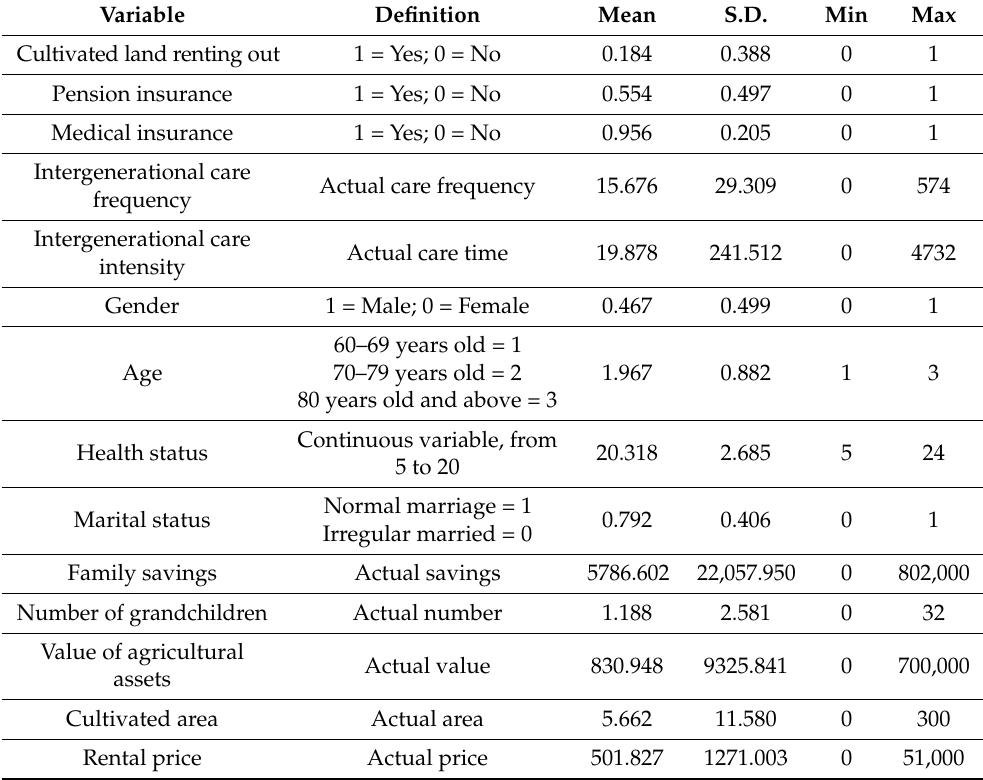
Table 1. Definitions and descriptive statistics of the